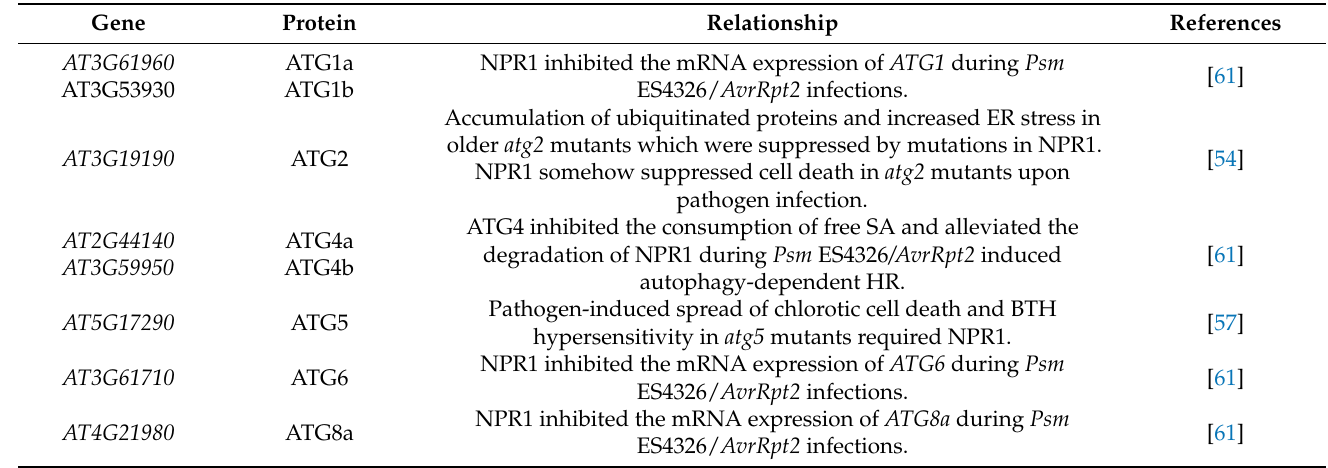
Table 2. Relationship between ATGs and NPR1 in Arabidopsis